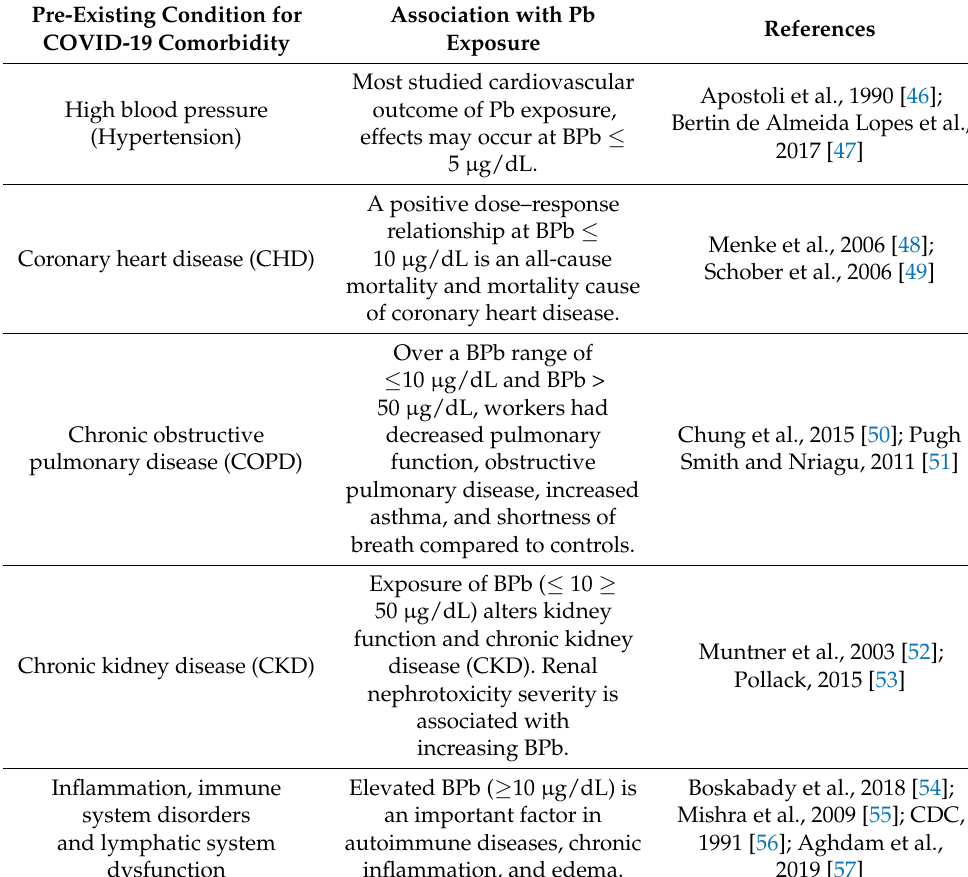
Table 3. Pb exposure and COVID-19 comorbidity